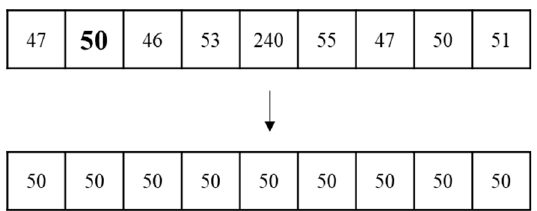
Figure 2. (Top) The original one-dimensional array, in which the median of all the elements is 50. (bottom) The new one-dimensional array consists of the median, 50, for all its elements.